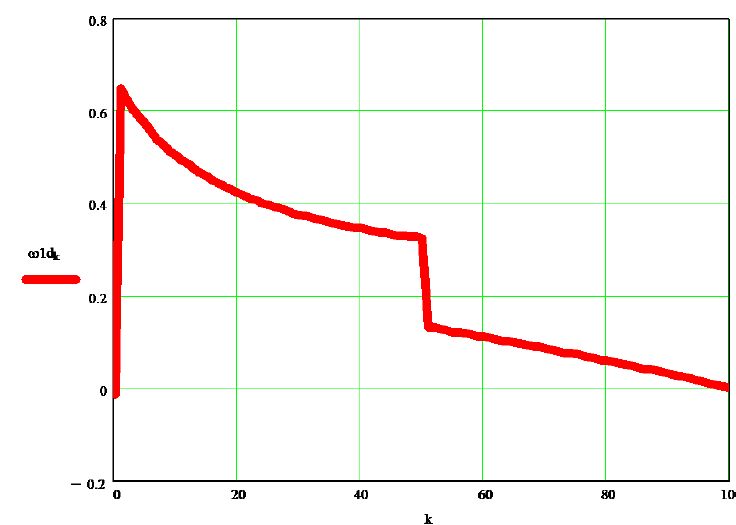
Figure 9. The original dynamic angular velocity w 1 d .